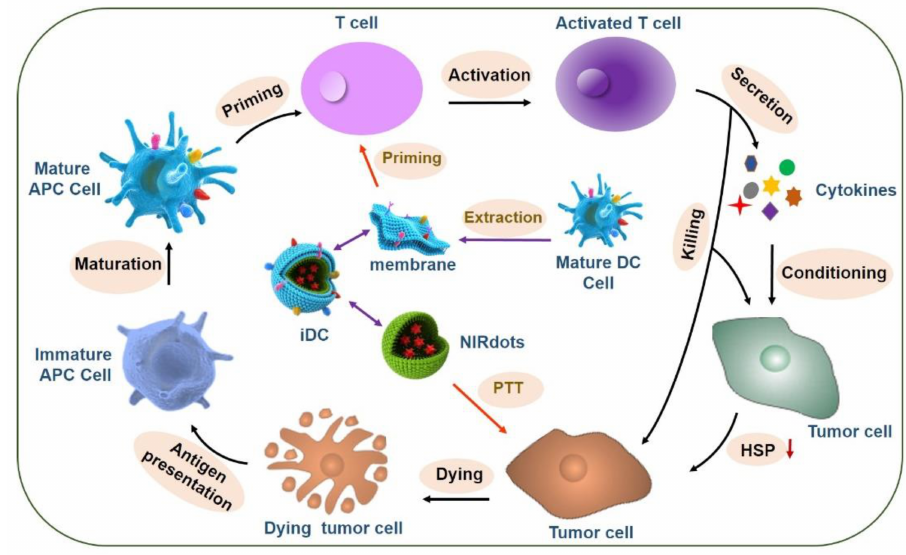
Figure 3. Schematic illustration of the preparation of intelligent dendritic cells (iDCs) and the mechanism of synergy between iDCs and mild